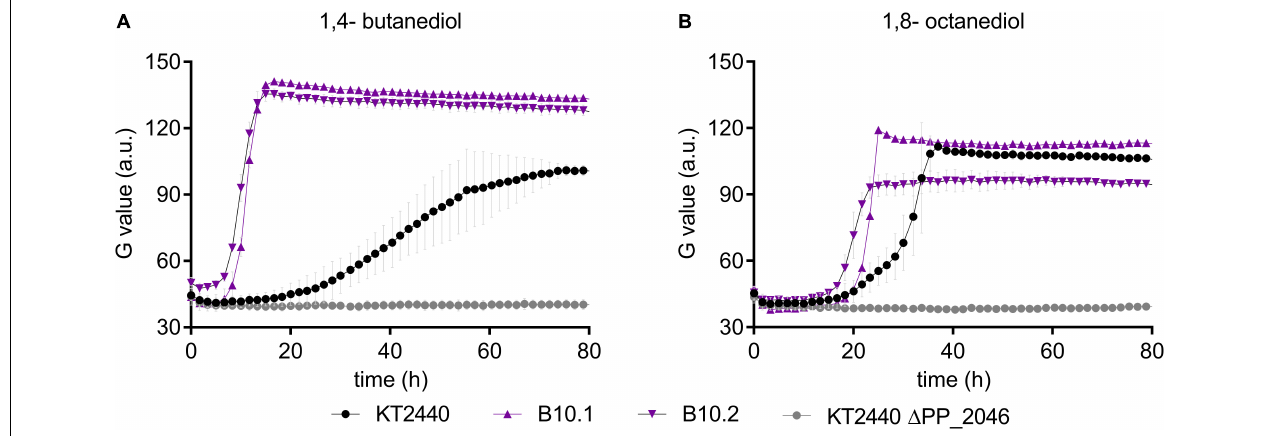
FIGURE 6 | Growth of P. putida KT2440 (black, circles), B10.1, B10.2 (purple, triangles) and (cid:49) PP_2046 (gray, circles) on 1,4-butanediol (A,B) 1,8-octanediol. Growth was detected via a Growth Profiler R (cid:13) in 24-square well plates. Error bars depict the deviation from mean ( n =